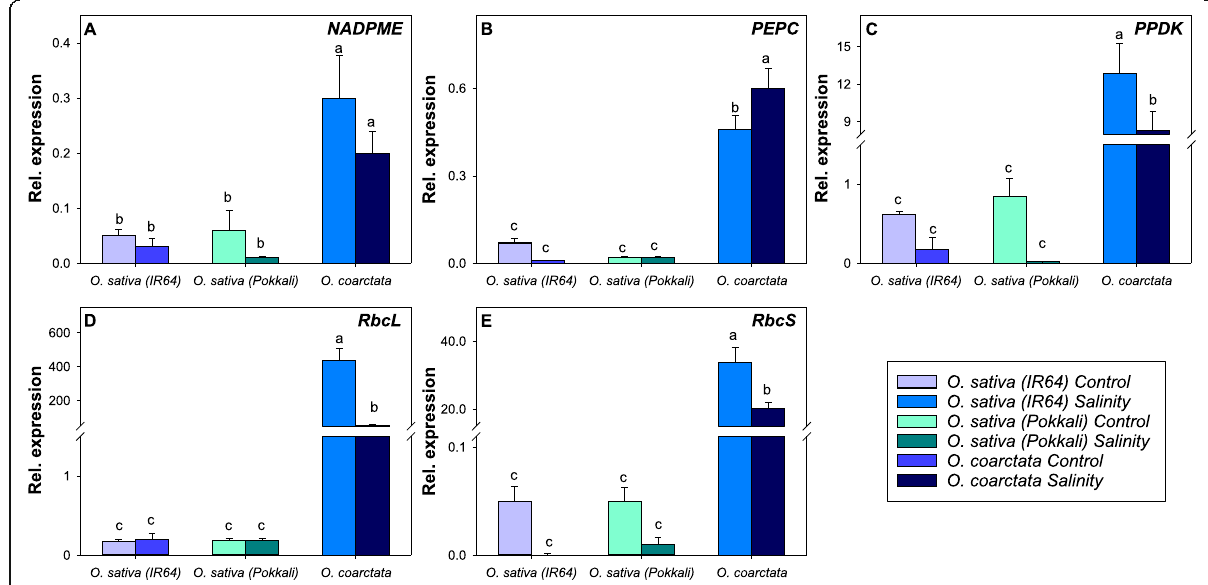
Fig. 9 Molecular evidence for O. coarctata being a C 3 -C 4 intermediate. Effect of salinity on the following C 4 photosynthesis-related genes in O. coarctata, Pokkali and IR64: ( A ), NADP-dependent malic enzyme ( NADPME ), ( B ) PEPC, ( C ) PPDK, ( D ) RBCL , and ( E ) RBCS. Data are means and the error bars indicate the standard errors. Different lowercase letters indicate significant differences at P < 0.05 for each Duncan